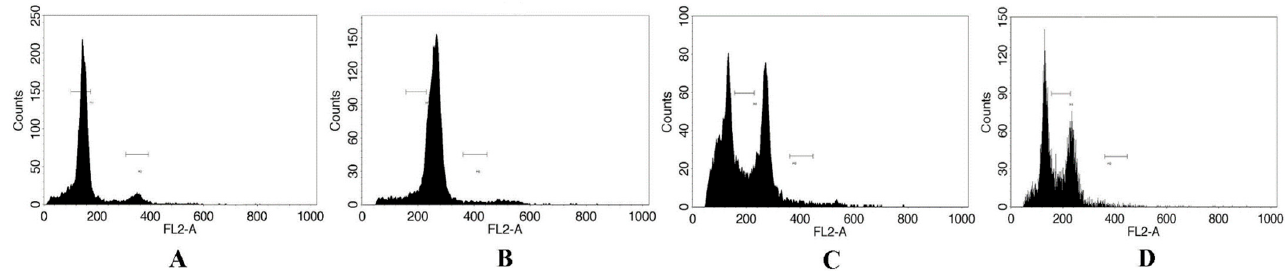
Figure 9. Determination of ploidy levels of several mutants in F. nilgerrensis by flow cytometry. ( A ) WT; ( B ) RL; ( C ) WL; ( D ) SGL.